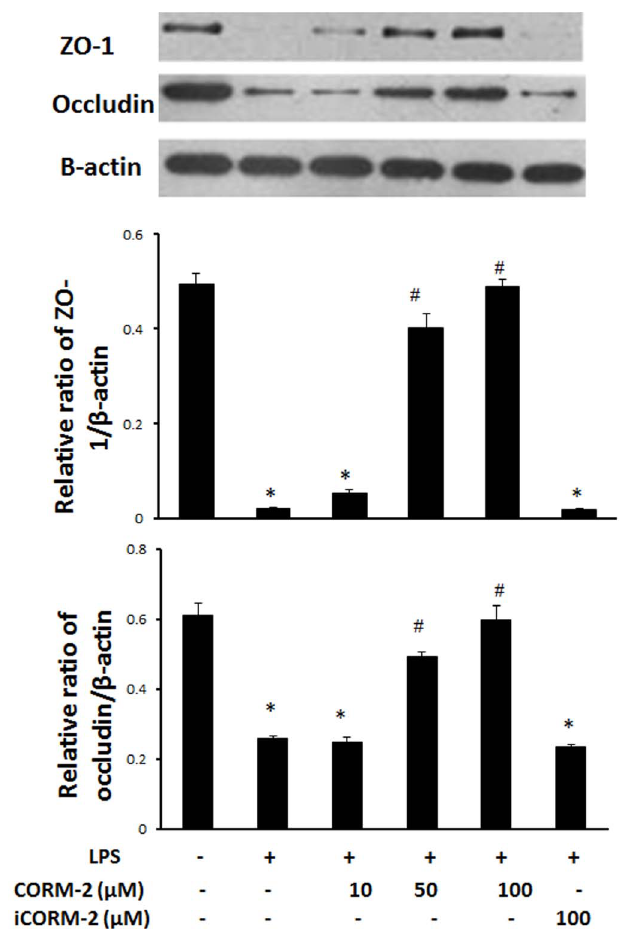
Figure 4. Effect of CORM-2 on TJ protein expression in LPS-treated IEC-6 cells. IEC-6 cells were pretreated with CORM-2 for 1 h and the cells were washed and stimulated with 50 m g/ml LPS for 24 h. The cells were washed with PBS and harvested with RIPA buffer. The protein concentration was determined and proteins subjected to Western blotting (Methods). A typical image is shown (Upper panel). The relative ratios (Mean 6 SD) of ZO-1/ b -actin (Middle panel) and occludin/ b -actin (Lower panel) are calculated based on the densities of bands on Western blots from 3 independent experiments. *ANOVA test, P , 0.05 when compared to control group (no treatment), # ANOVA test, P , 0.05 when compared to LPS alone